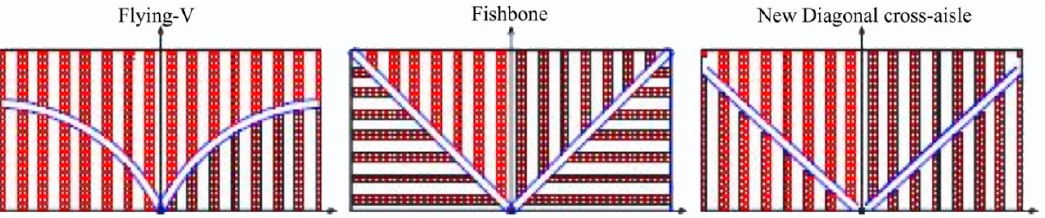
Figure 2. Flying-V, Fishbone, New Diagonal cross-aisle layouts.